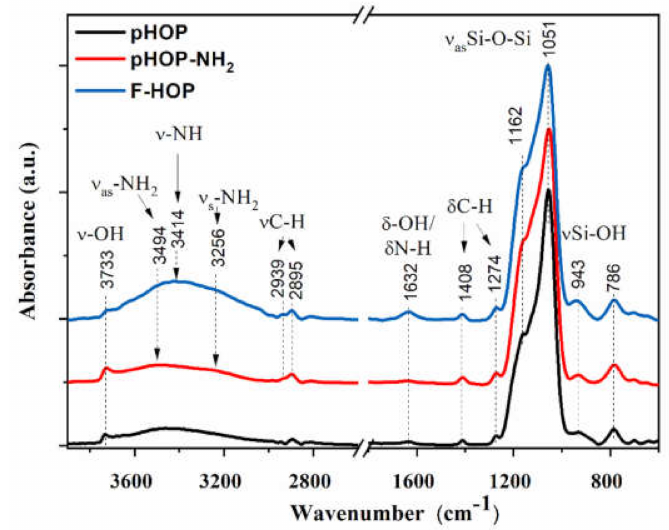
Figure 5. FT-IR spectra of unmodified pHOP (black line), pHOP-NH 2 (red line) and F-HOP (blue line) samples. Spectra are normalized to the strongest Si-O-Si band intensity and are shifted vertically for better visualization.